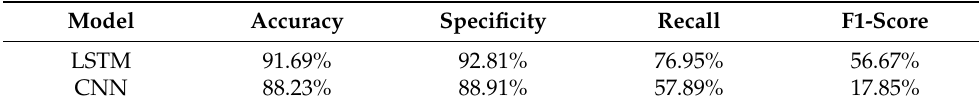
Table 1. Performance evaluation